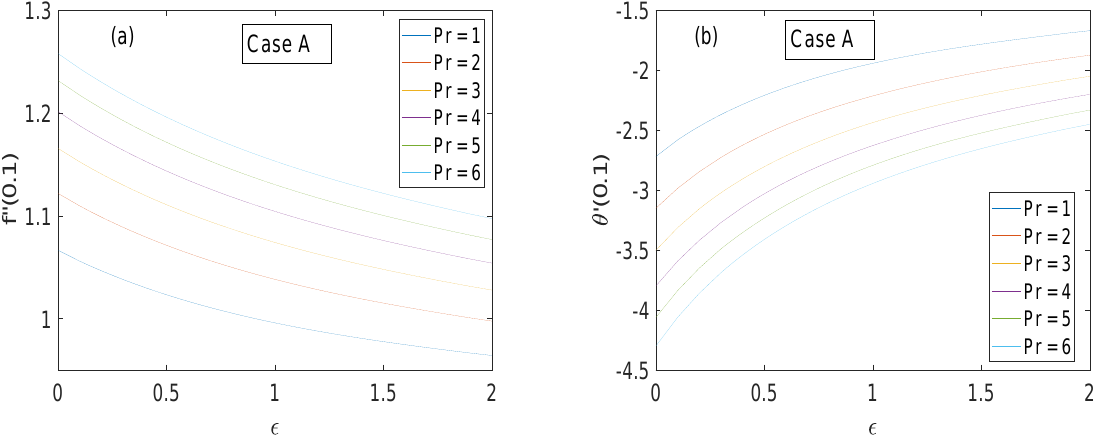
Figure 8. Axial velocity and temperature profiles for different values of 𝑚 when 𝜆 (cid:3404) 0.8 , Pr (cid:3404) 5 , 𝜃 (cid:3050) (cid:3404) 1.27 and 𝜖 (cid:3404) 0.5. Part ( a ) shows function 𝑓′ , while the function 𝜃 is plotted in part ( b ).